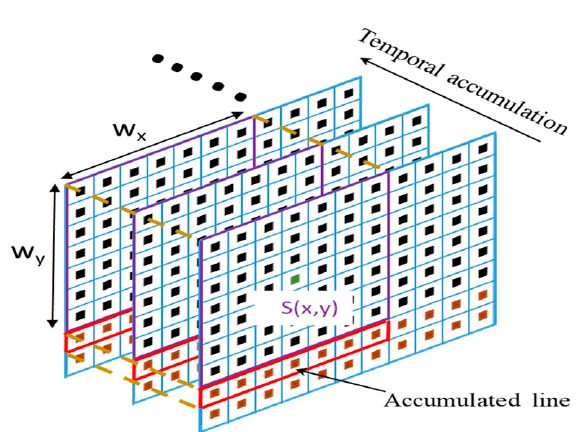
Figure 5. Spatiotemporal box filter.